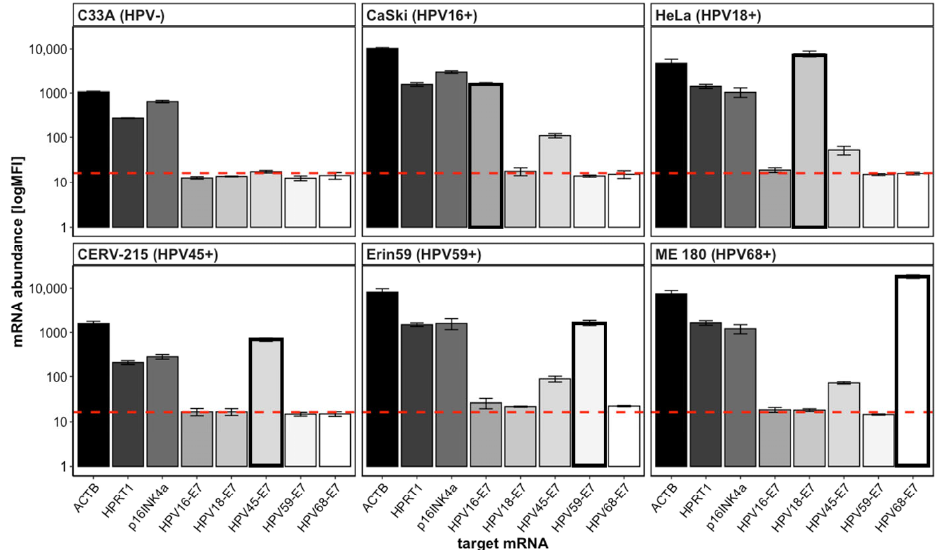
Figure 1. HPV-E7 and cellular mRNA detection and quantitation by QG-POC assay. Cell lysates representing approximately 4000 cells of the indicated cell lines were subjected to a QG-POC assay. Mean MFI (+/ − SD, n = 3) values of the mRNA abundance are shown for the included target mRNAs. Bold framed columns indicate the E7 mRNA result for the intrinsic genotype of the given cell line. The dashed red line indicates the mean LOD (NC plus 3 × SD) of all the markers tested.